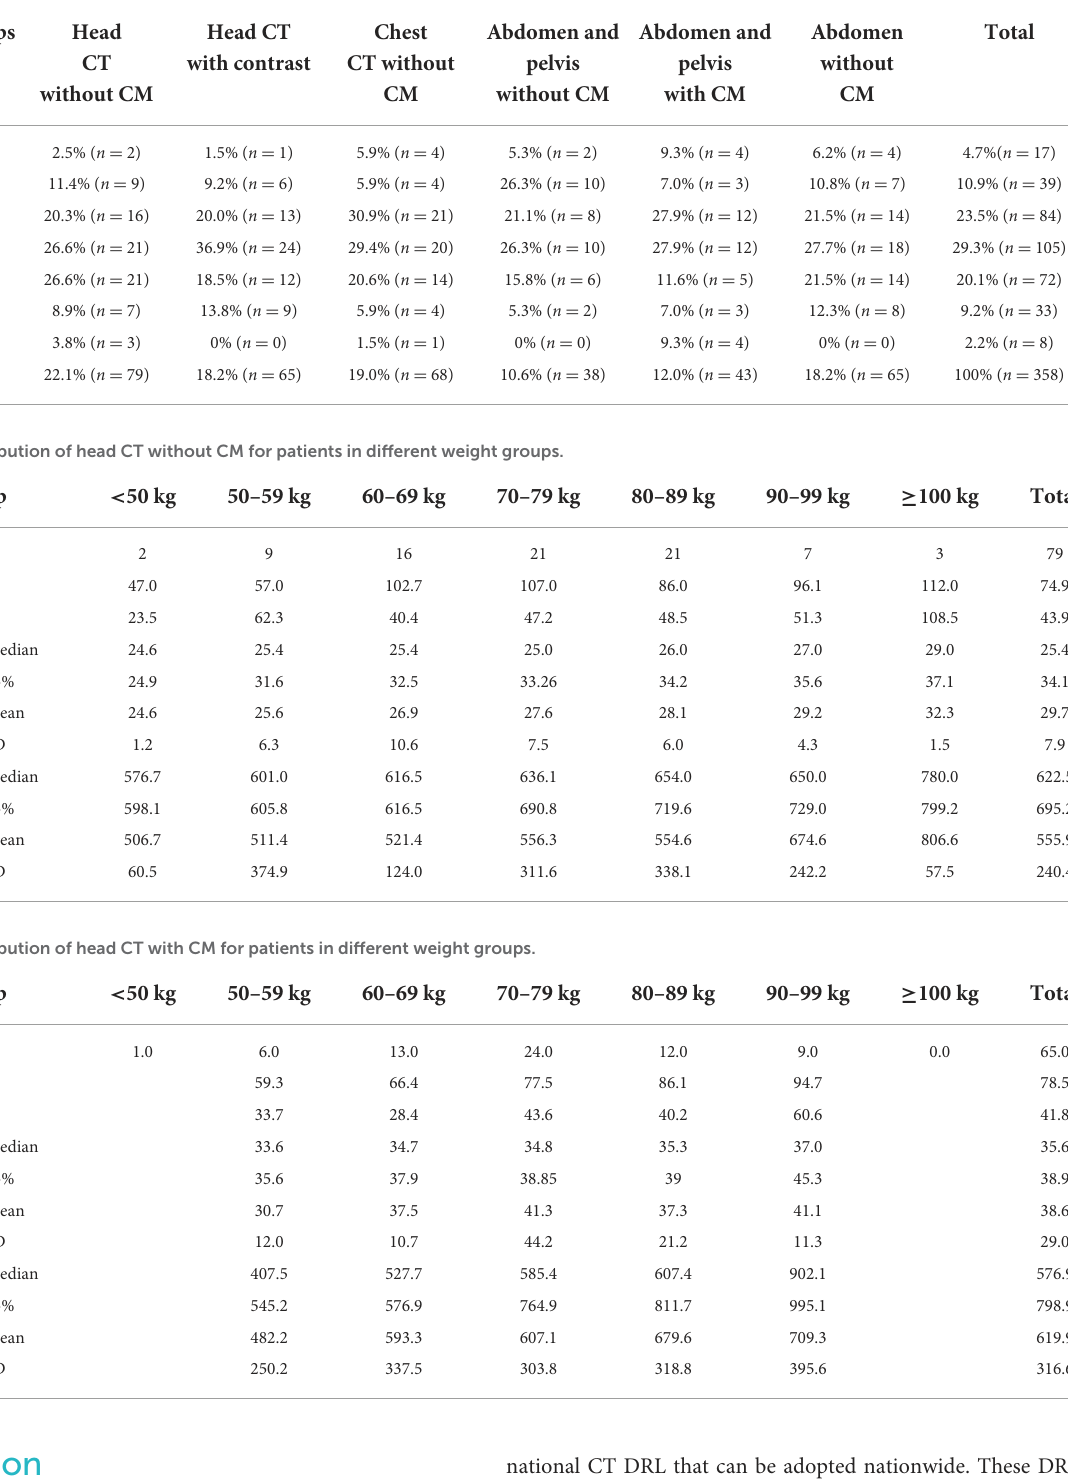
TABLE 1 Frequency of weight groups.